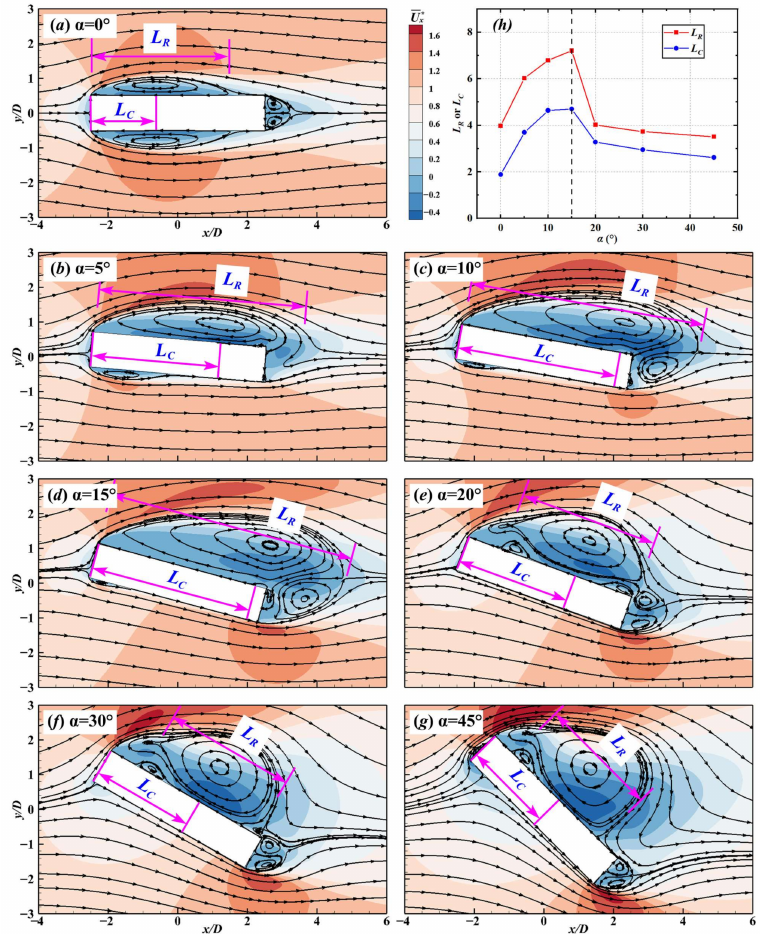
Figure 11. Time-averaged streamwise velocity contour and time-averaged streamline distribution. ( a ) α = 0 ◦ , ( b ) α = 5 ◦ , ( c ) α = 10 ◦ , ( d ) α = 15 ◦ , ( e ) α = 20 ◦ , ( f ) α = 30 ◦ , ( g ) α = 45 ◦ , ( h ) The trend of L R or L C with the increase in the